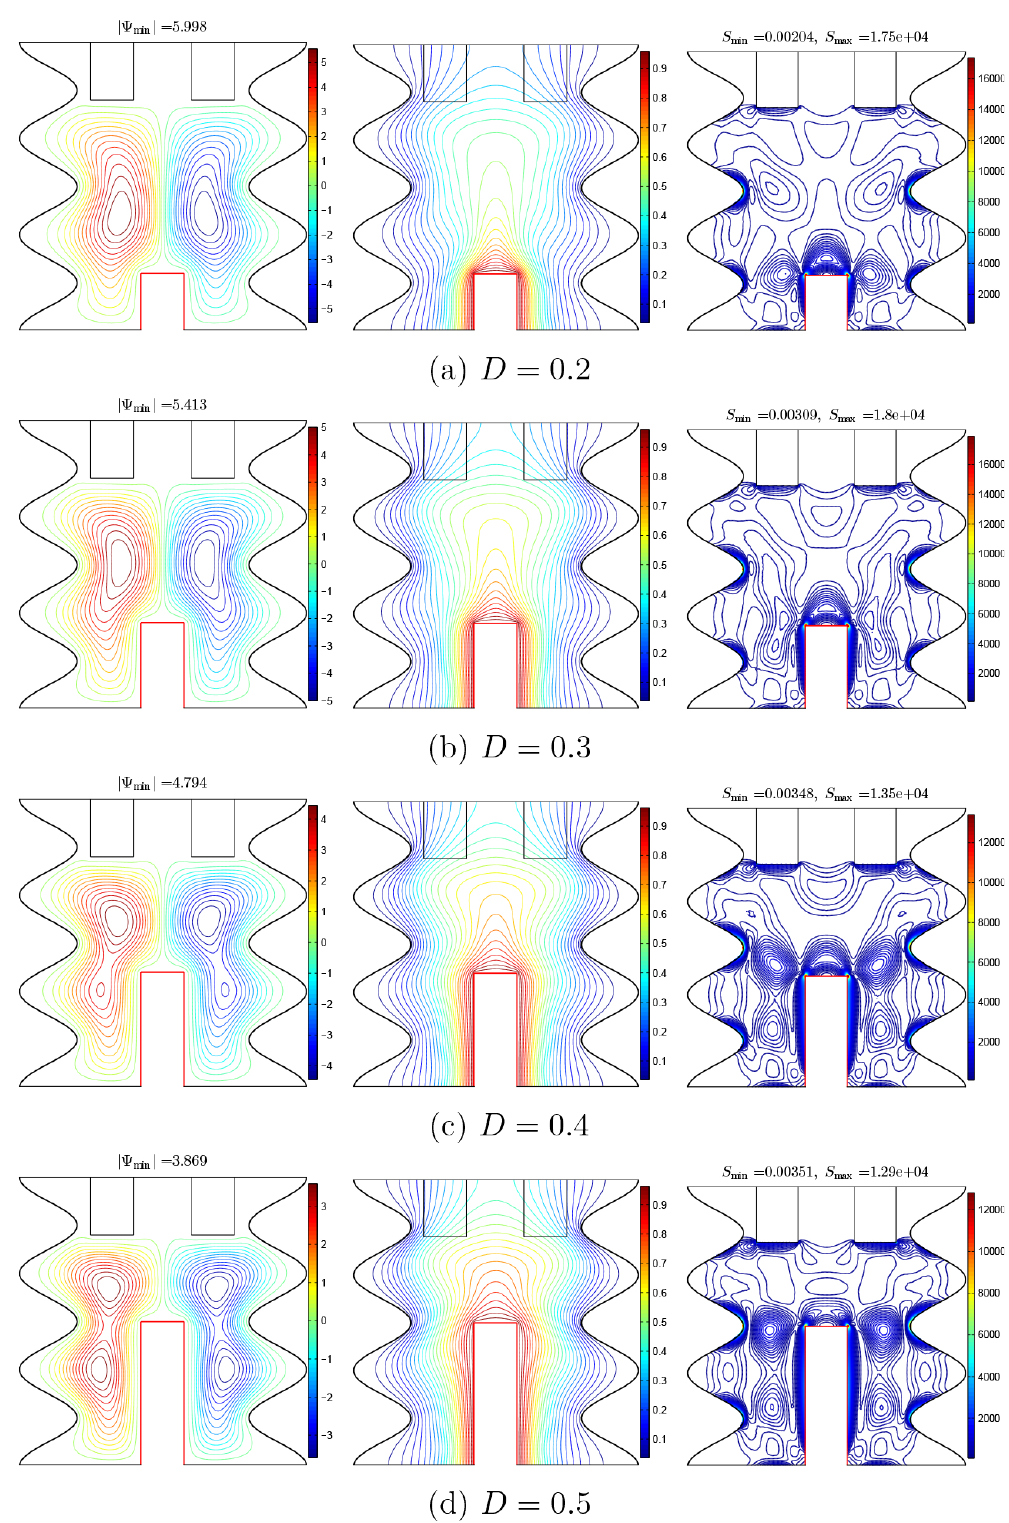
Figure 13. Evaluation of the streamlines ( left ), temperature contours ( middle ), and entropy patterns ( right ) for various dimensionless heat source lengths ( D ) in the case of hybrid nanofluids when Ra = 10 5 and φ =